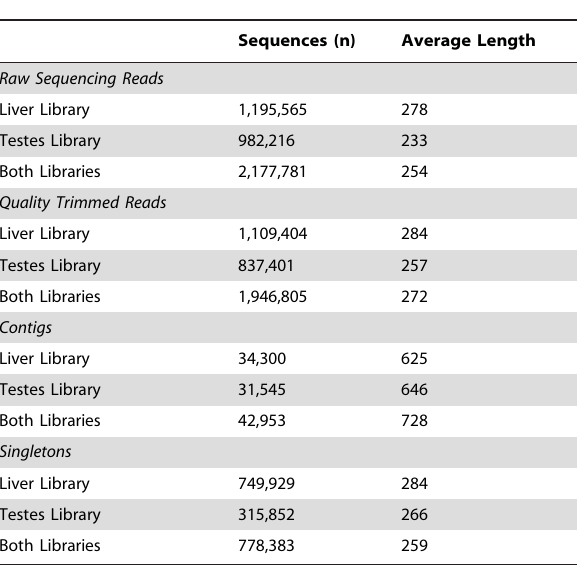
Table 1. Characteristics of Pacific herring hepatic and testicular transcriptome